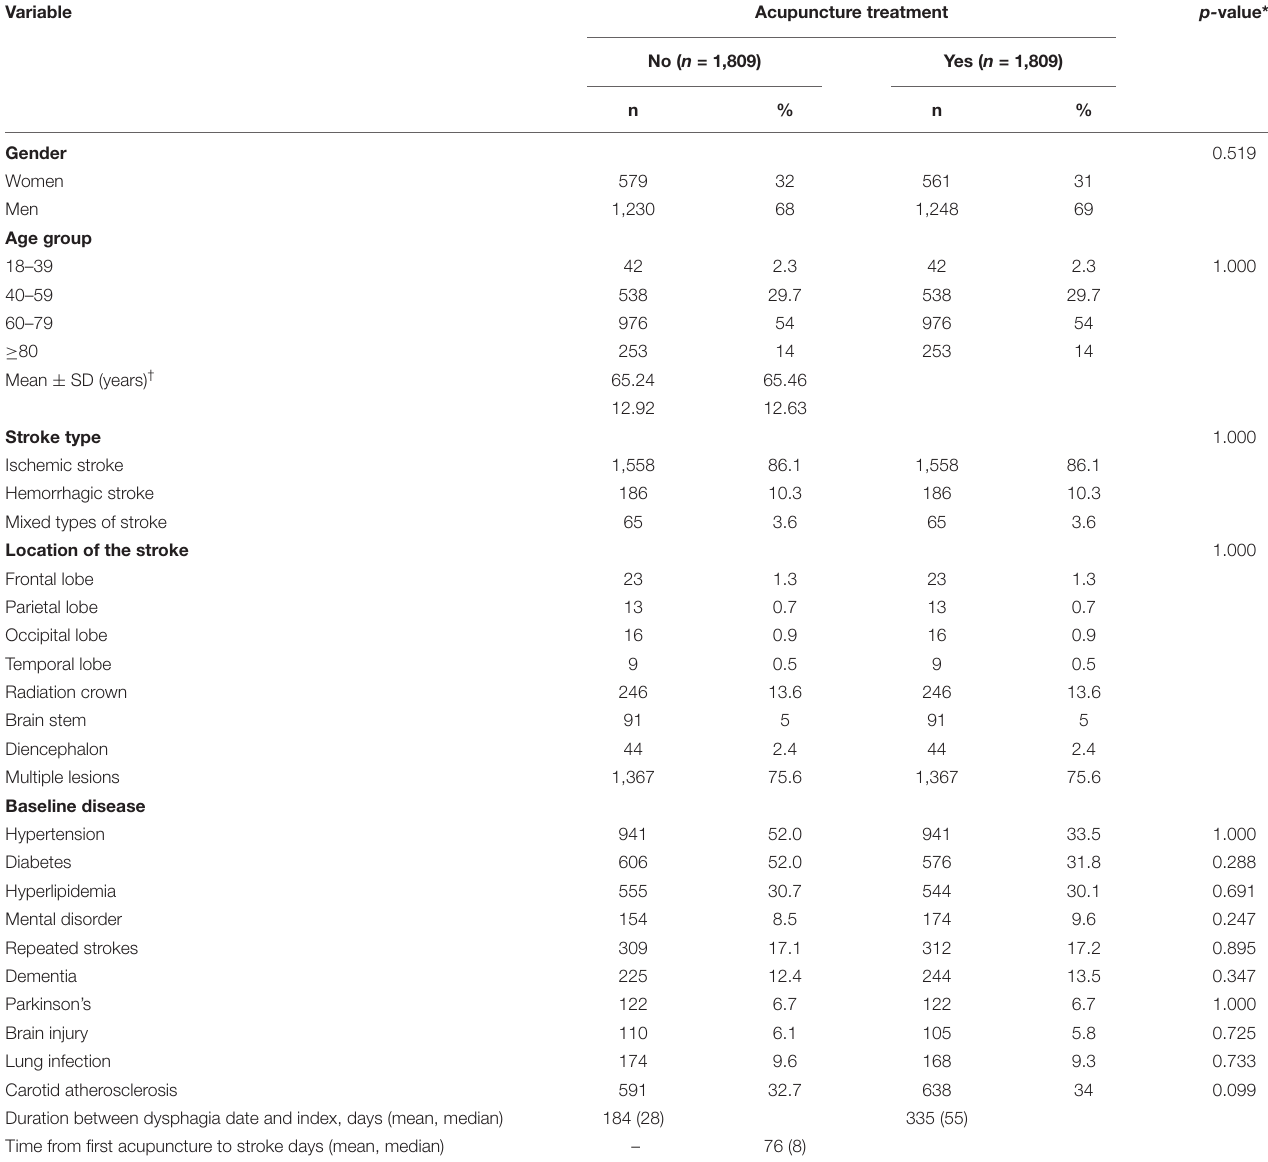
TABLE 1 | Characteristics of stroke